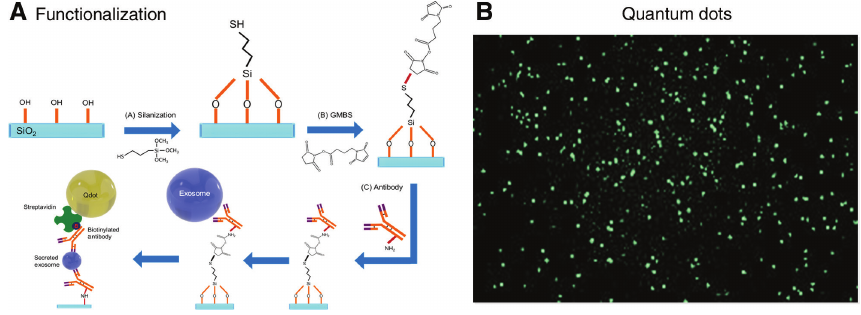
Figure 5: Functionalization and quantification of exosomes using quantum dots. (A) Flowchart to functionalize the optical sensors in order to quantify exosome secretions. (B) Fluorescent images were processed through haze reduction and black balance algorithms, and Q-dots (number of quantum dots) were counted using the object counter module in the microscope software (BZ-II Analyzer).